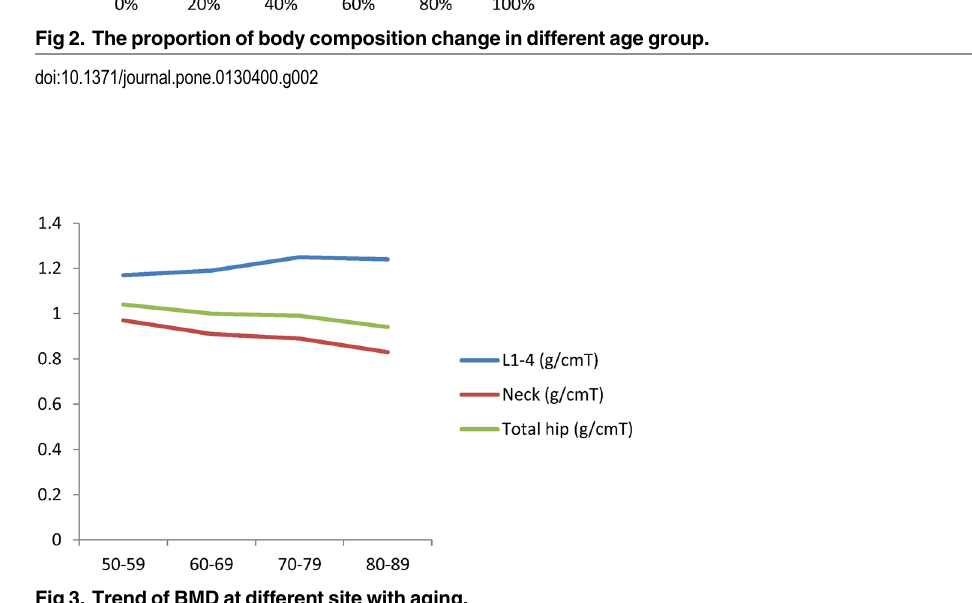
Fig 3. Trend of BMD at different site with